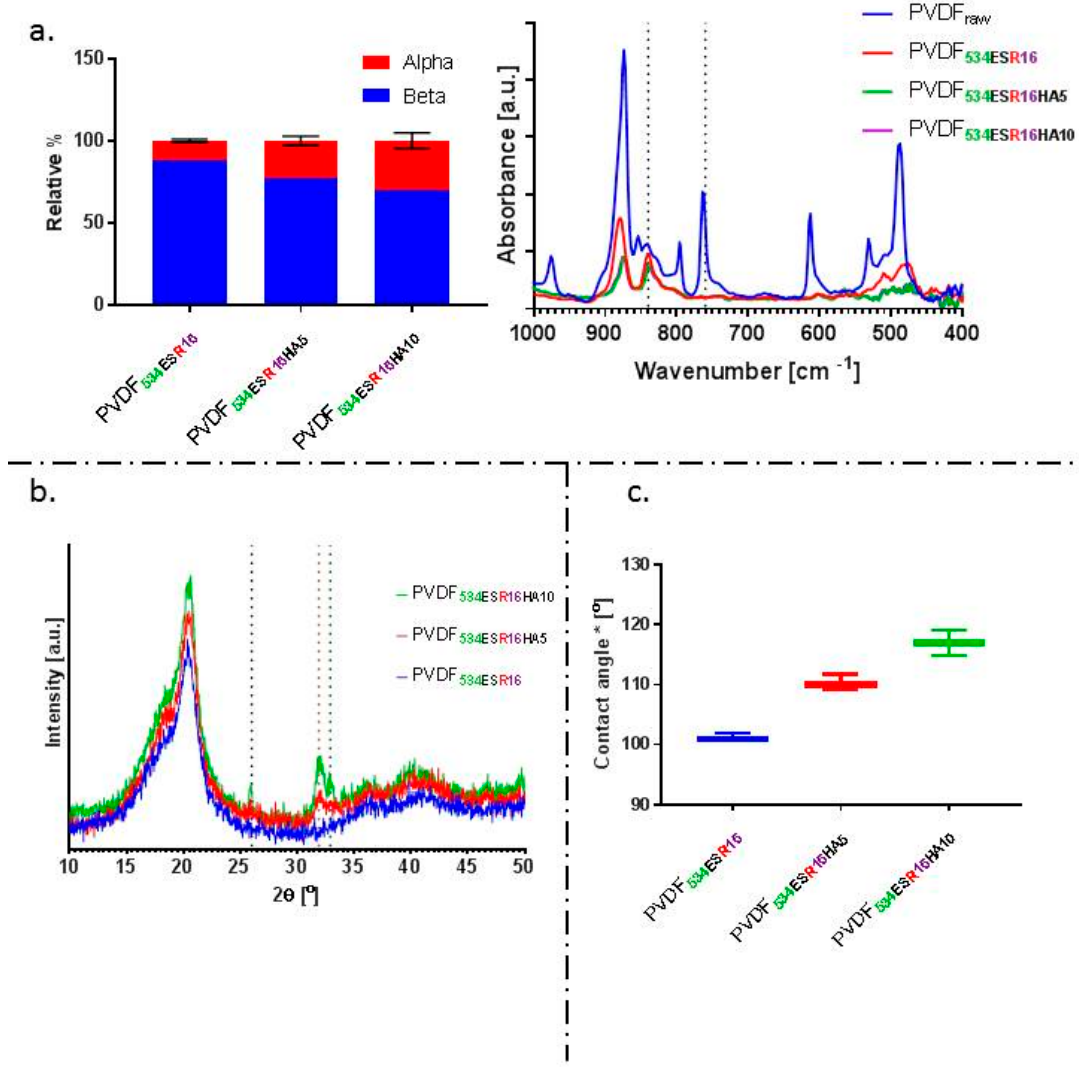
Figure 7. ( a ) Relative% of α - and β -phase and representative FTIR spectra of electrospun HA / PVDF composite fibre mats. A reduction of β -phase from 88.02% in PVDF 534ESR16 fibres to 77% and 70% was observed for PVDF 534ESR16HA5 and PVDF 534ESR16HA10 composites, respectively. ( b ) X-RD graphs of the composite fibres obtained. ( c ) The apparent water-in-air* contact angle of the composite fibre mats obtained.